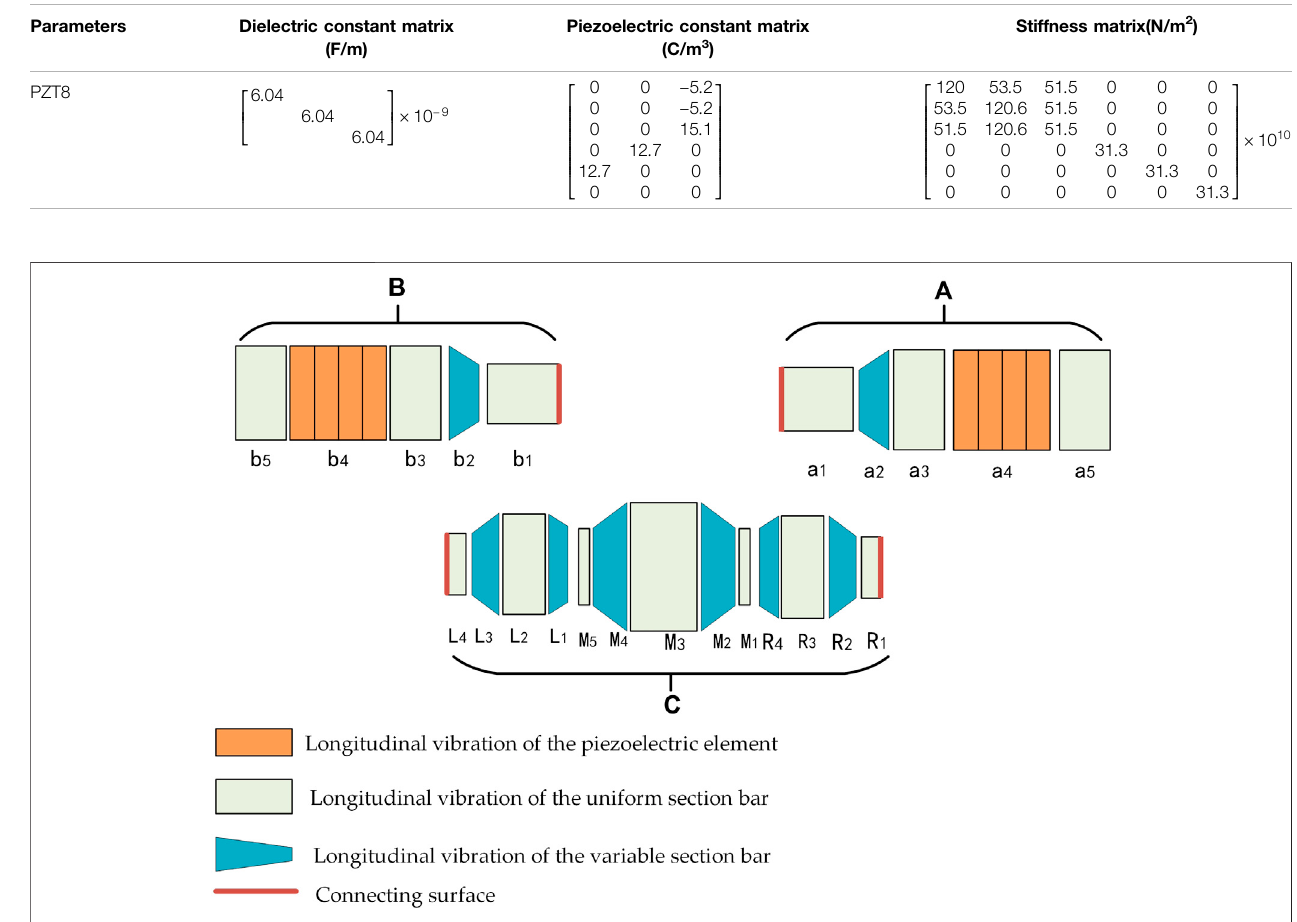
FIGURE 4 | Discrete model of the push-pull